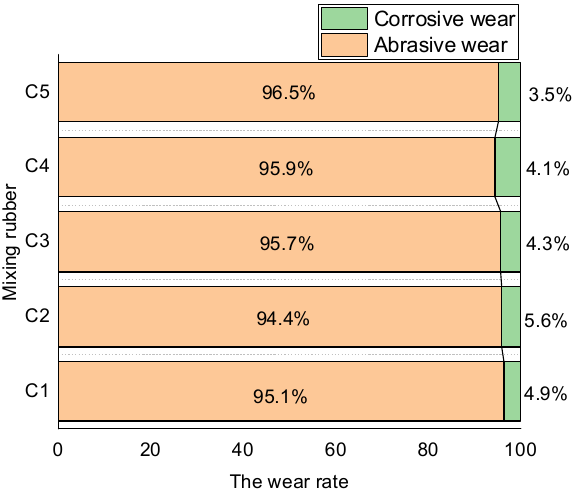
Figure 14. Metal wear volume without spraying the ethanol–water mixture.